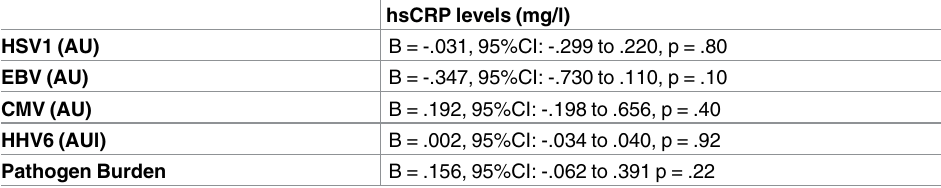
Table 3. Associations between level of viral antibodies and hsCRP levels. hsCRP levels (mg/l) HSV1 (AU) B = -.031, 95%CI: -.299 to .220, p = .80 EBV (AU) HHV6 (AUl) B = .002, 95%CI: -.034 to .040, p = .92 Pathogen Burden B = .156, 95%CI: -.062 to .391 p = .22 hsCRP = high sensitive C-reactive protein, HSV1 = herpes simplex virus type 1 antibody levels in the seropositive group (N = 287), EBV = Epstein barr virus antibody levels in the seropositive group (N = 296), CMV = cytomegalovirus antibody levels in the seropositive group (N = 298), HHV6 = human herpes virus 6 antibody levels in the seropositive group (N = 1082). Pathogen Burden = analysed in total population (N = 1220), AU = arbitrary units. All analyses were adjusted for sex, BMI and depressive